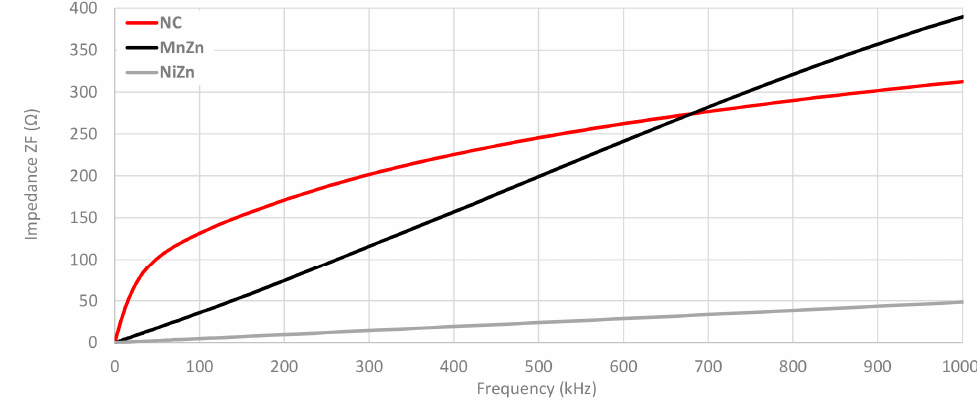
Figure 11. Impedance comparison of the three cable ferrites measured with 2 turns.